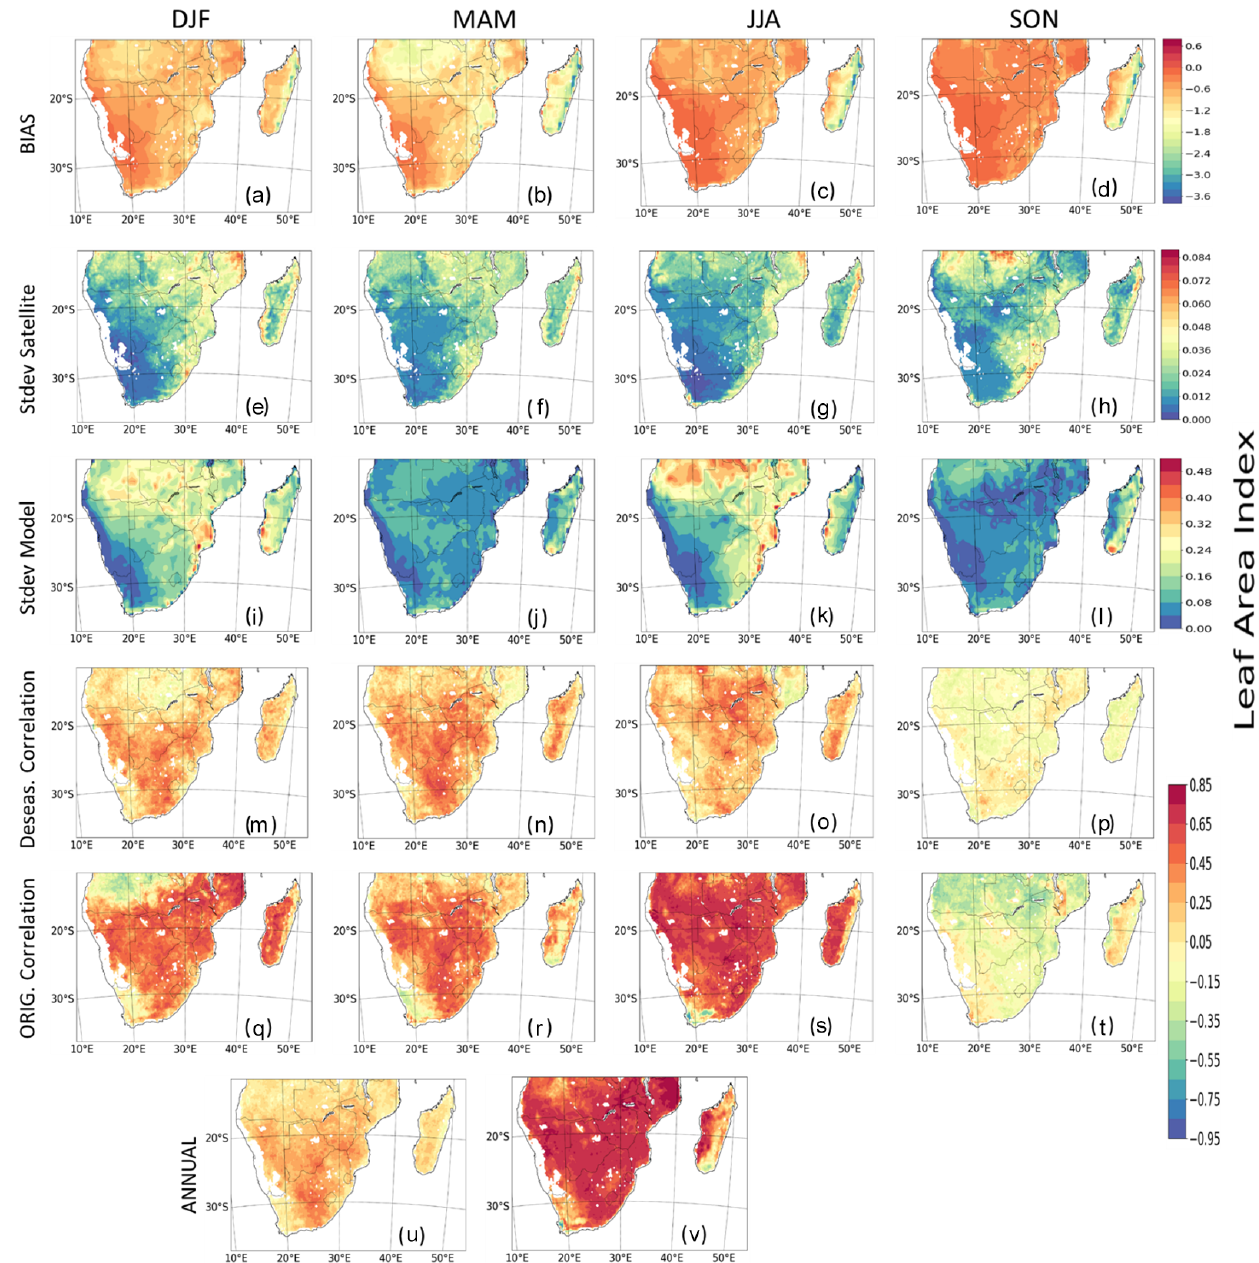
Figure 3. Spatial seasonal distribution and interannual variability (IAV) of satellite-calculated and modelled LAI (multimodel mean) over southern Africa. Panels (a–d) show the difference (bias). Panels (e–h) and (i–l) show their standard deviation (SD). Panels (m–p) show the correlations between deseasonalized GIMMS LAI and modelled LAI. Panels (q–t) show their correlations for original GIMMS LAI and modelled LAI. Panels (u) and (v) show correlations between GIMMS LAI and modelled LAI but for the period 1982–2011. The interannual variability for observed and modelled LAI for the period 1982–2011 is shown in Fig.